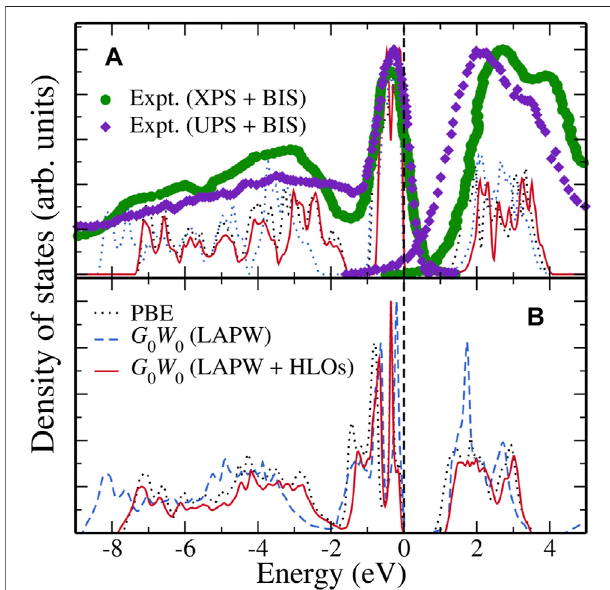
FIGURE 5 | Density of states (DOS) computed from PBE (black dotted), G 0 W 0 @PBE with the standard LAPW basis (blue dashed) and G 0 W 0 @PBE with the LAPW + HLOs basis (red solid) for (A) pyrite and (B) marcasite FeS 2 . Energy distribution curves (EDCs) of pyrite extracted from photo- electron spectroscopy (PES) are presented for comparison. Each dataset is normalized with respect to its highest peak. Theoretical data are aligned to its valence band maximum as energy zero. The XPS + BIS and UPS + BIS data for pyrite are obtained from Folkerts et al. (1987) and Mamiya et al. (1997), respectively. To take into account the different de fi nitions of the Fermi level in theory and experiment, a rigid shift of 0.60 and 0.40 eV are employed for the EDCs from XPS + BIS and UPS + BIS, respectively, to match the highest valence peaks below the Fermi